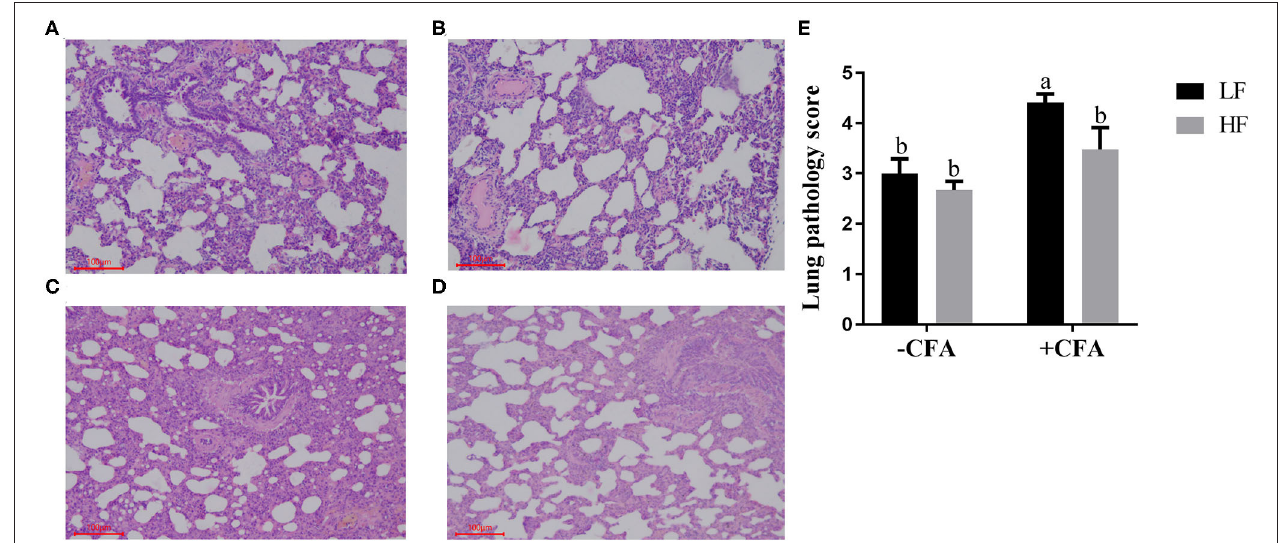
FIGURE 3 | Effect of dietary fiber and CFA on pathological slices in lungs of piglets. (A) LF without CFA challenge; (B) HF without CFA challenge; (C) LF with CFA challenge; (D) HF with CFA challenge. Original magnification 200 × ; stained with hematoxylin and eosin staining. a,b Mean values within a row with different superscript letters were significantly different ( p < 0.05). (E) Histogram of lung pathology score